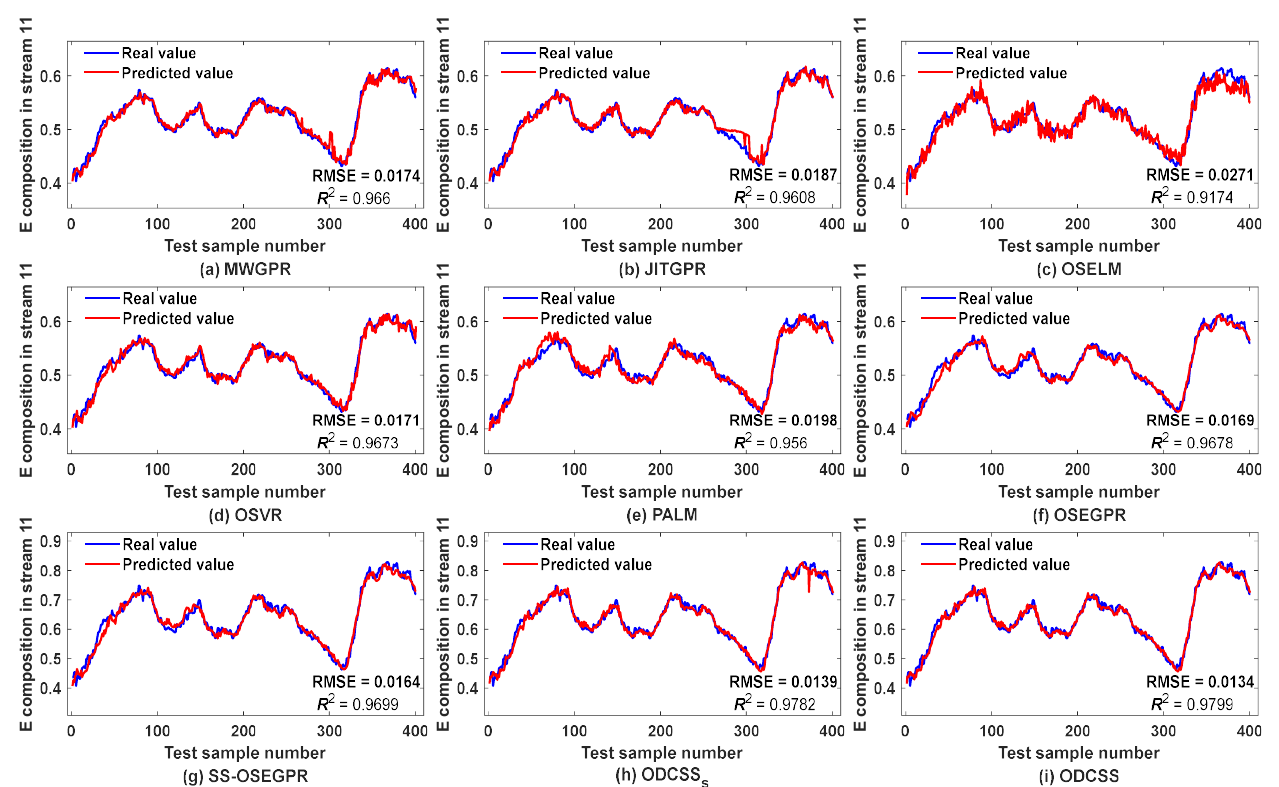
Figure 4. Prediction trends of E component in stream 11 by different soft sensor methods.